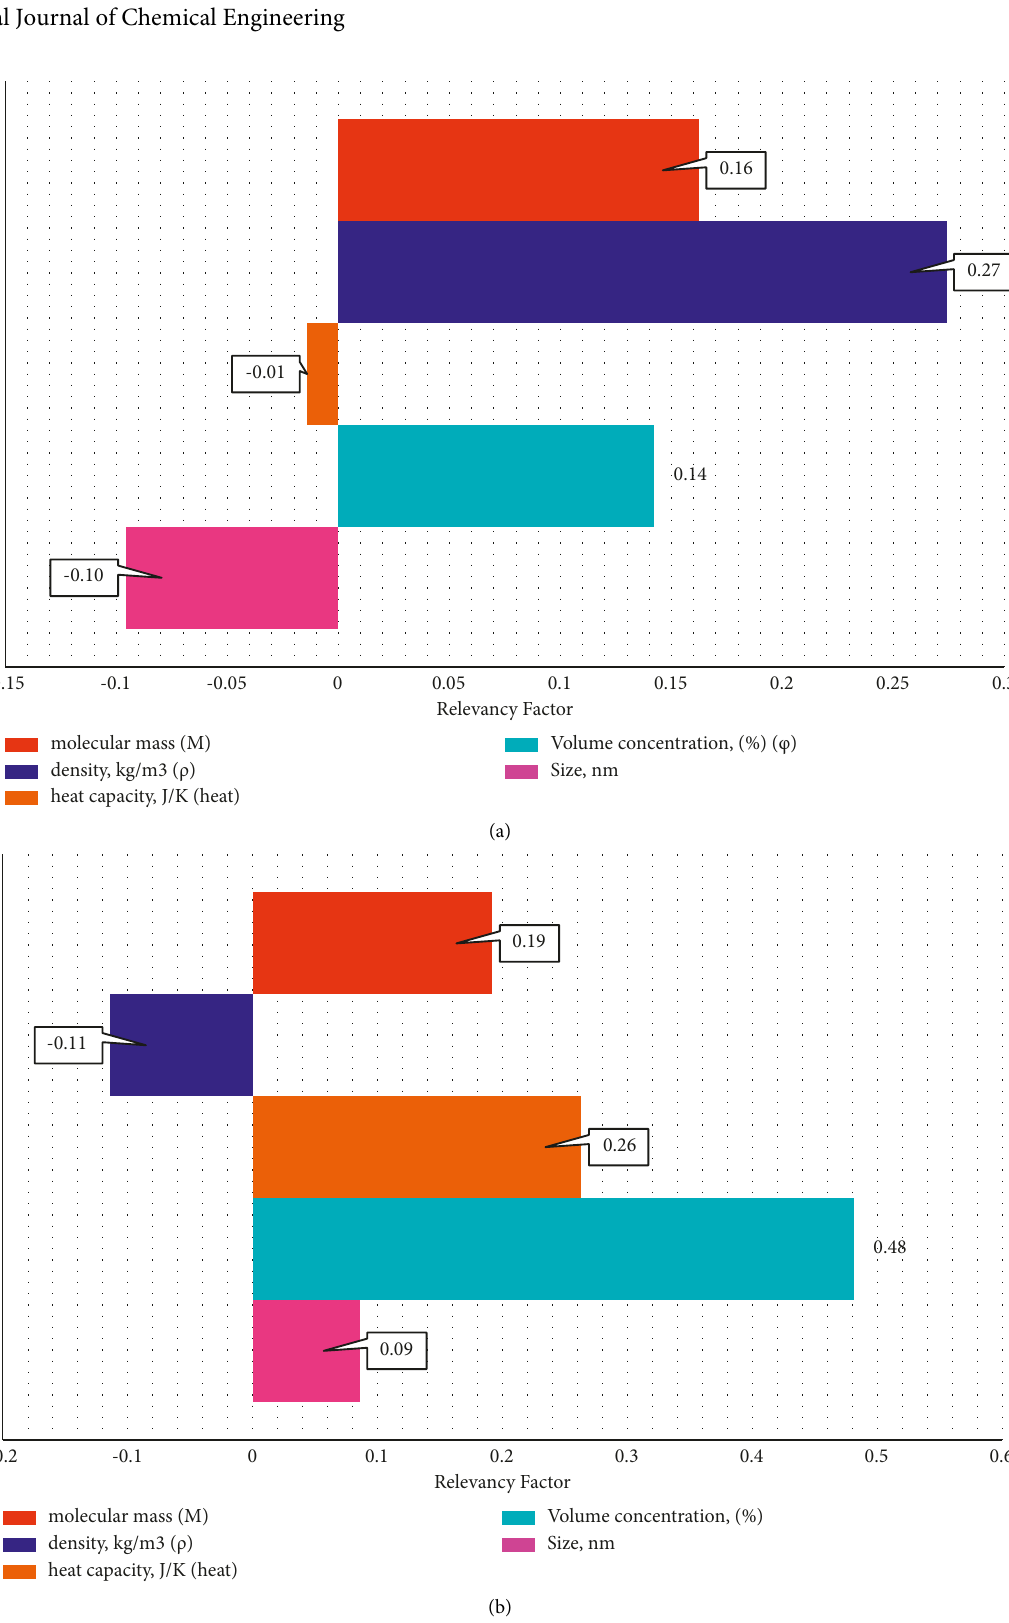
Figure 6: Sensitivity analysis for data related to the (a) TC ratio and (b) relative viscosity of